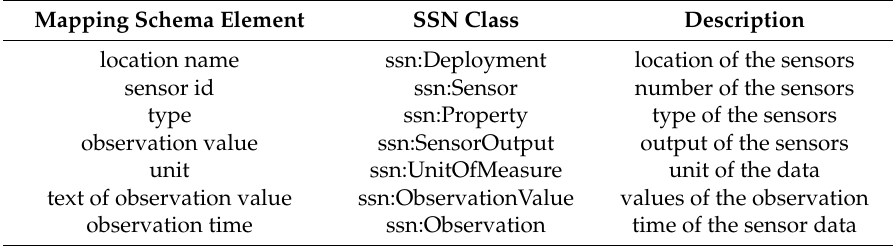
Table 1. Correspondences between the elements in the mapping schema and the classes in SSN (from